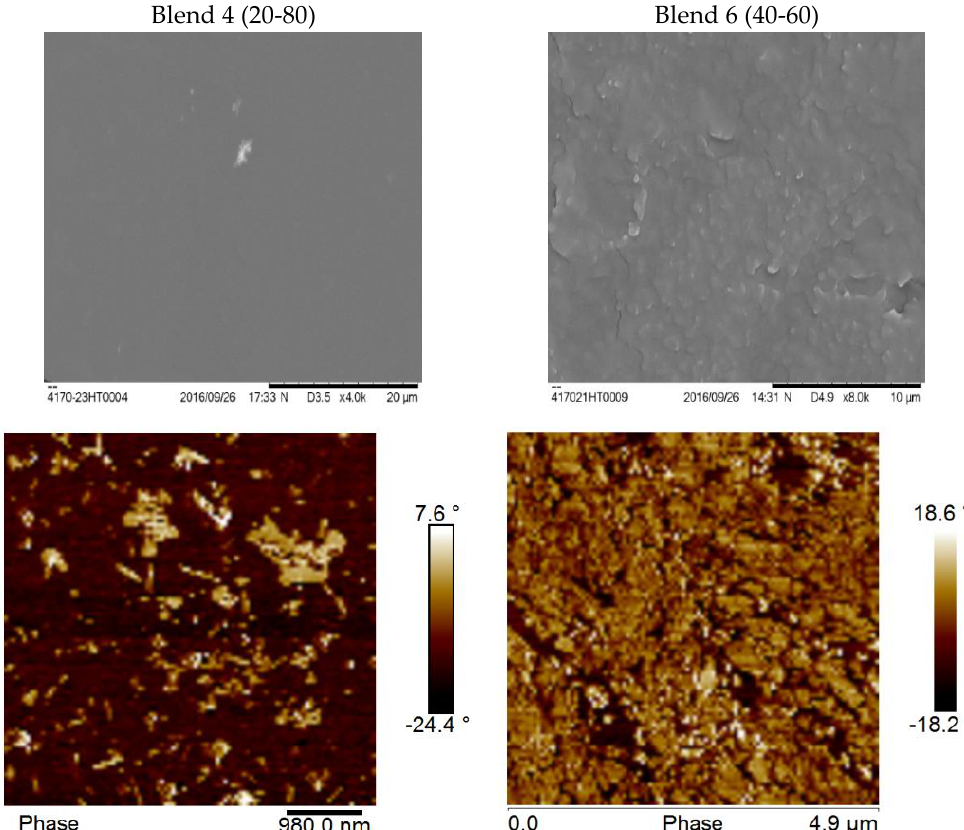
Figure 5. SEM and AFM phase images of SS-adhesive interface after detachment (the adhered tapes on SS annealed for 10 min at 60 °C and cooled to room temperature).